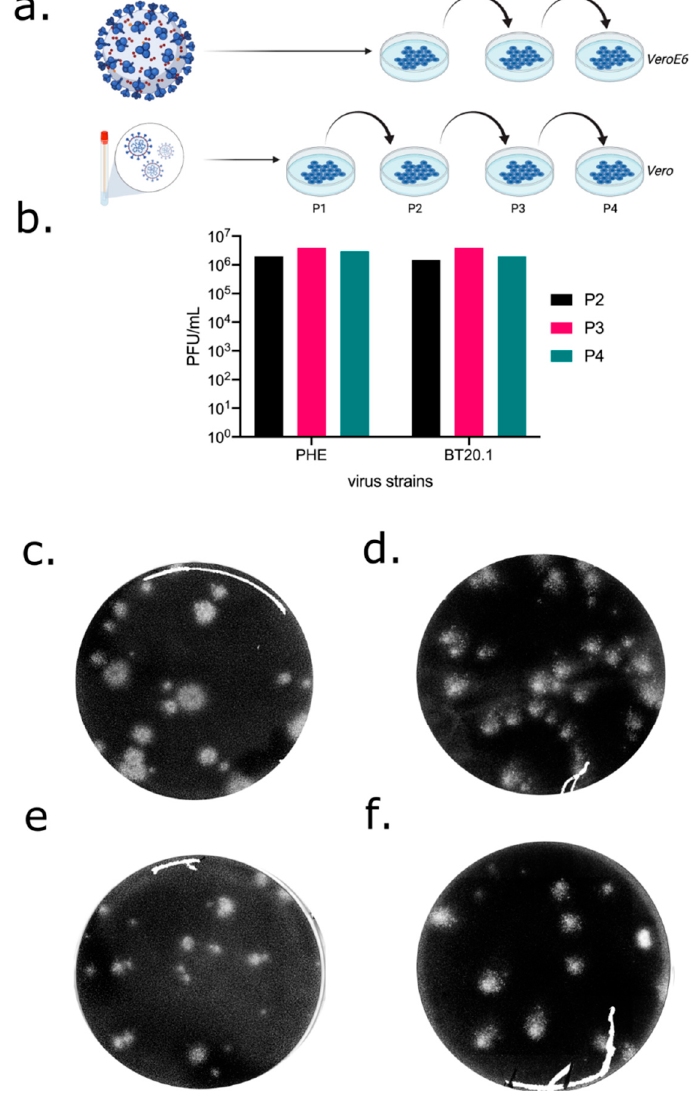
Figure 1. Isolation and passage of PHE and BT20.1 in Vero-derived cells . Schematic of SARS-CoV-2 isolation/serial passage series on VeroE6 or Vero cells for PHE and BT20.1 from isolation to P4 ( a ). Extracellular infectivity titres for stocks generated from P2–P4 VeroE6/Vero passage for PHE and BT20.1 using plaque assay protocol on Vero cells ( b ). Plaque visualisation of PHE ( c ) and BT20.1 ( d ) P4 and P2 ( e , f ) on Vero cells. Figures were generated with the aid of BioRender (https://biorender.com/ (accessed on 7 December